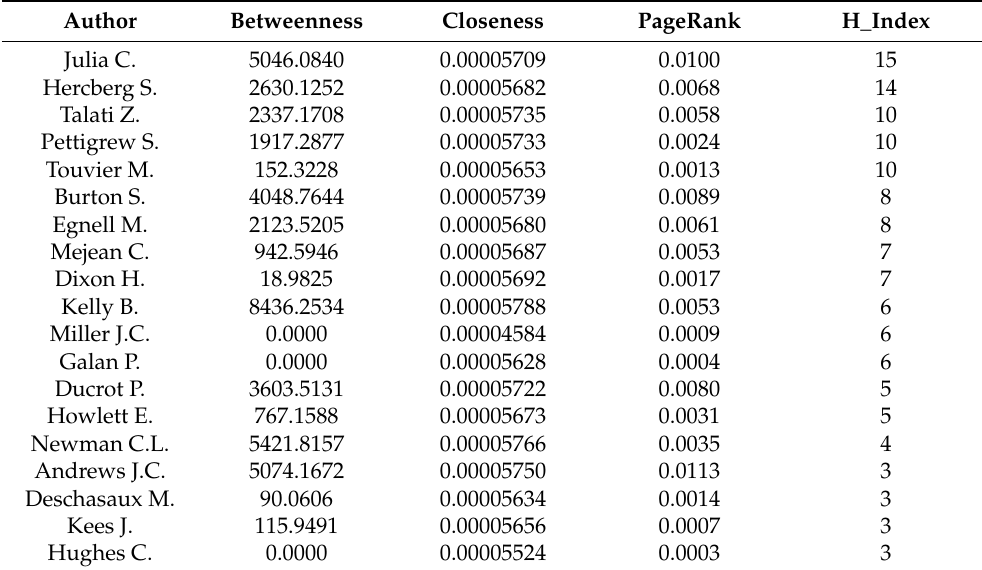
Table 16. Position of authors in the network and their measures. Authors in bold are those with a value above the mean.